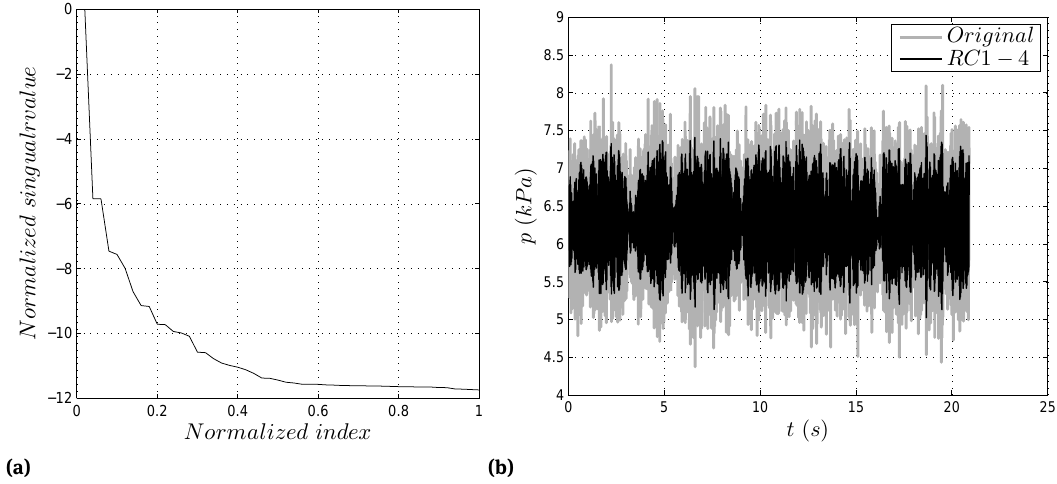
Figure 11: Source signal and sum of its three first principal components at deep surge (TOA = 5%) at the blower outlet